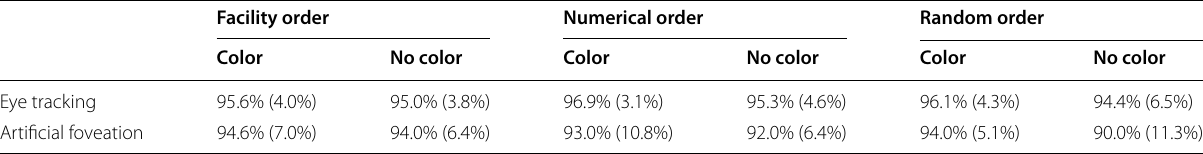
Table 1 Average accuracy (and standard deviation) for each list presentation condition for the eye tracking and artificial foveation experiments